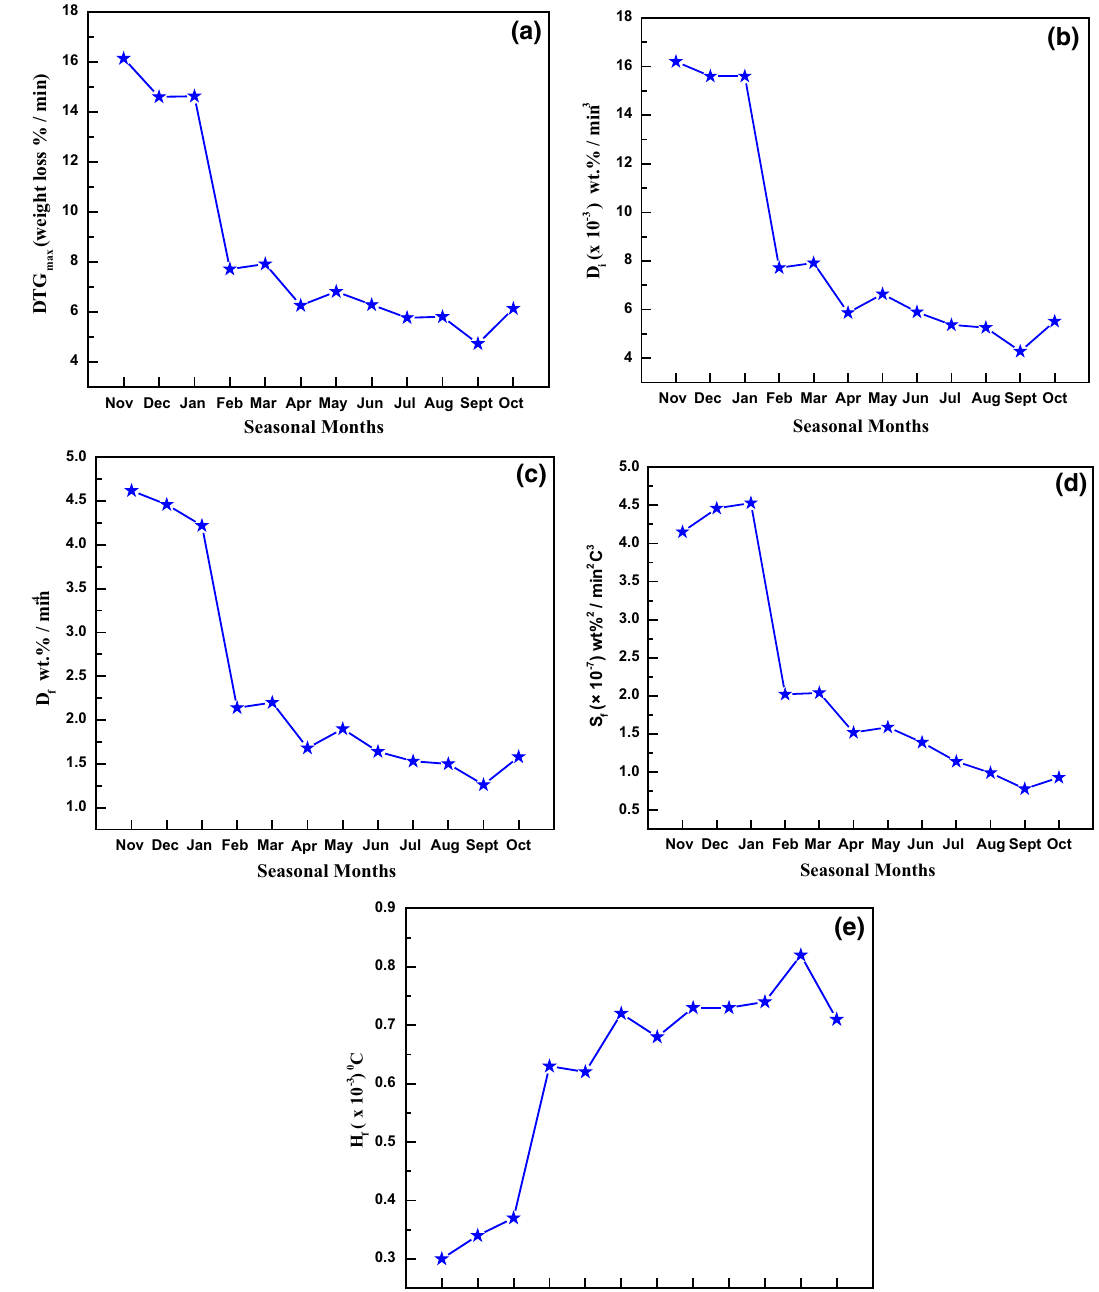
Fig. 8 Variation of a DTG max , b D i (ignition index), c D f (burnout index), d S f (combustion performance index), e H f (rate and heat intensity index) with eleven calendar months due to